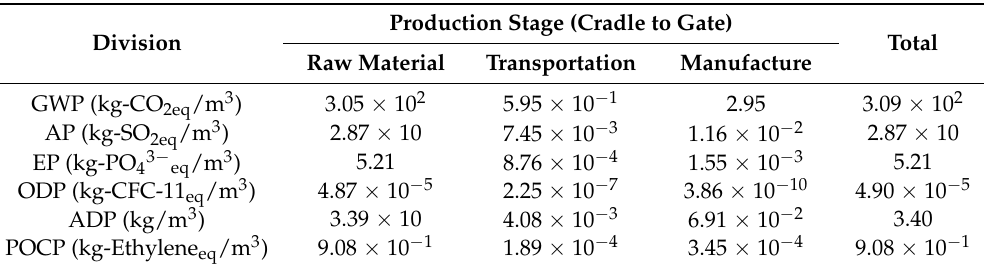
Table 8. Environmental impact assessment result.